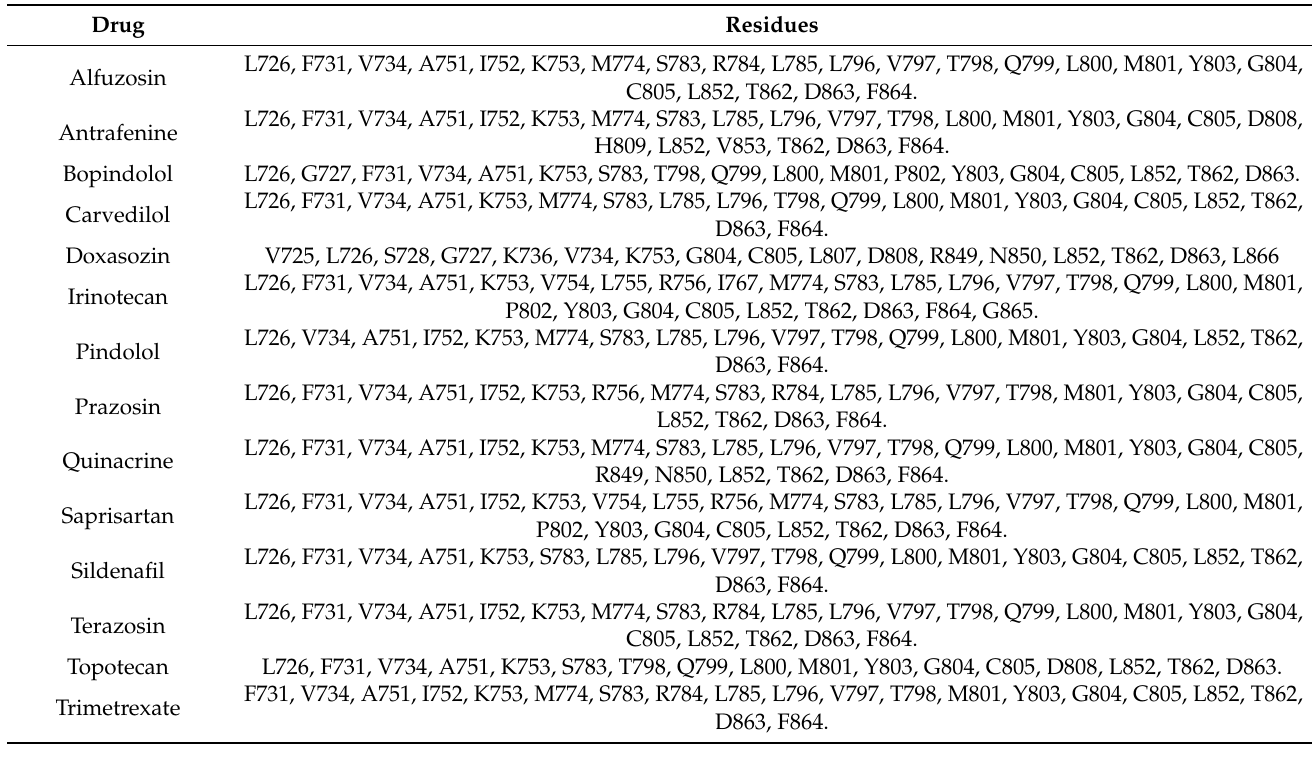
Table 1. Interactions between inhibitors selected in DrugBank and HER2 during